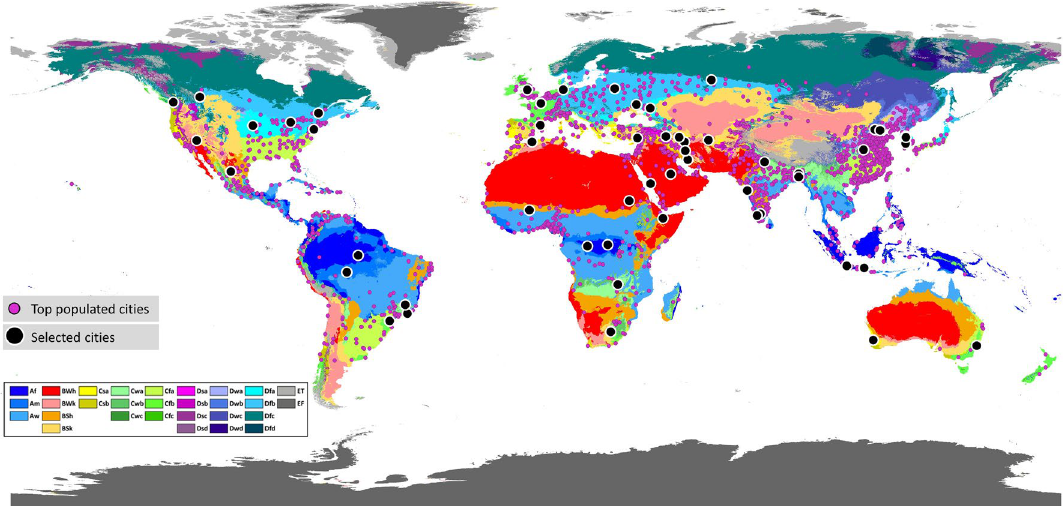
Figure 1. The distribution of the most populated cities and the selected cities for this study on the world map of Köppen–Geiger climate classification. Purple and black symbols depict the top populated cities around the world and the selected cities for this study, respectively (see “Methods” for the details on how to select cities). Cities are grouped by Köppen–Geiger climate classes: tropical, arid, temperate, and cold 33 . The legend in the lower left-hand corner indicates Köppen–Geiger climate subclasses. Cities were located on the map using ArcGIS 10.8 software (www. esri. com/ softw are/